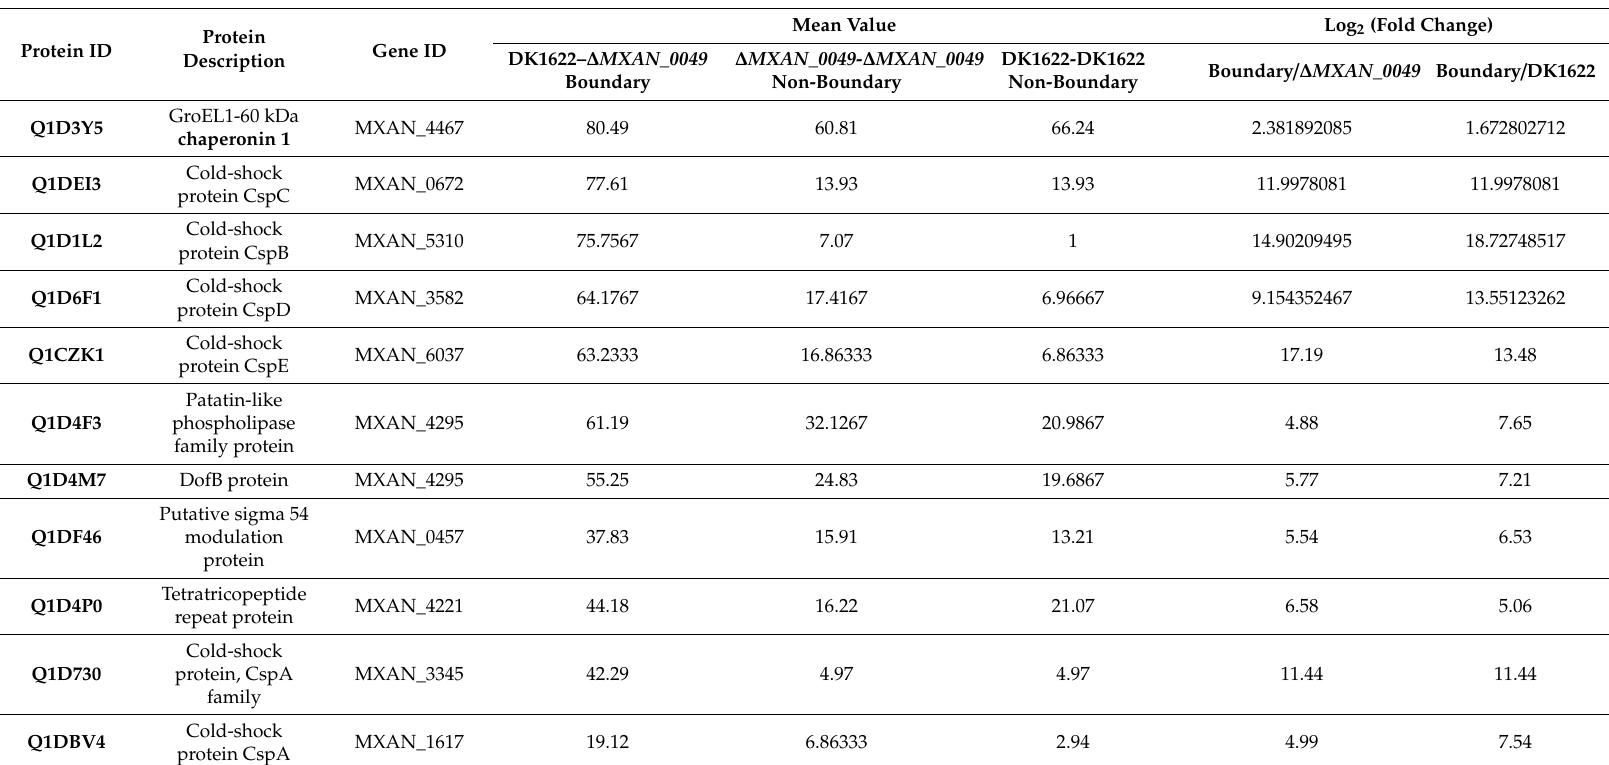
Table 1. List of upregulated proteins in the boundary compared to the non-boundary